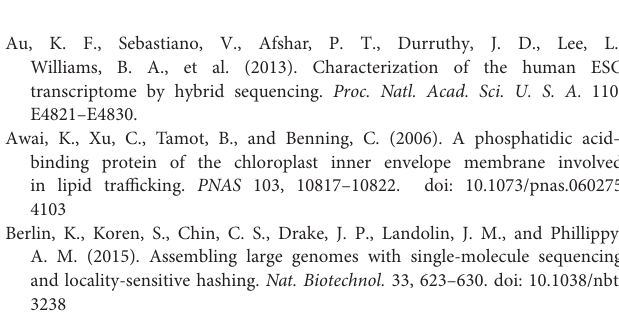
white light and dark treatment. Supplementary Table 9 | The overlapping genes in Gene ontology (GO) enrichment analysis result. Supplementary Table 10 | The alternative splicing type and expression level of the genes involved in the A. annua (dark as a control). Supplementary Table 11 | The alternative splicing type and expression level of the genes involved in the A. annua (white as a